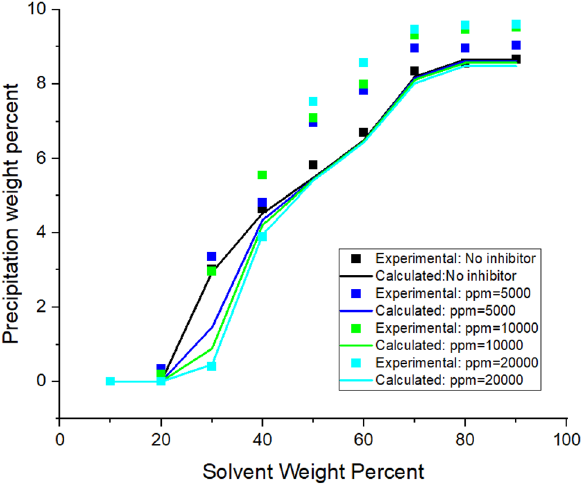
Figure 5. Asphaltene precipitation rate from the oil sample A in terms of solvent ratio with inhibitor (a = 3.38 × 10 11 and b = 24.51).